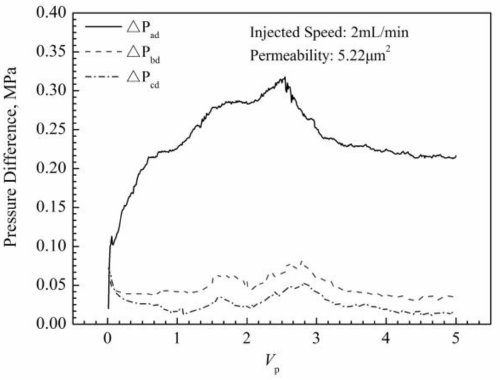
Figure 5. The change of subsequent water flooding pressure difference with injected pore volume.